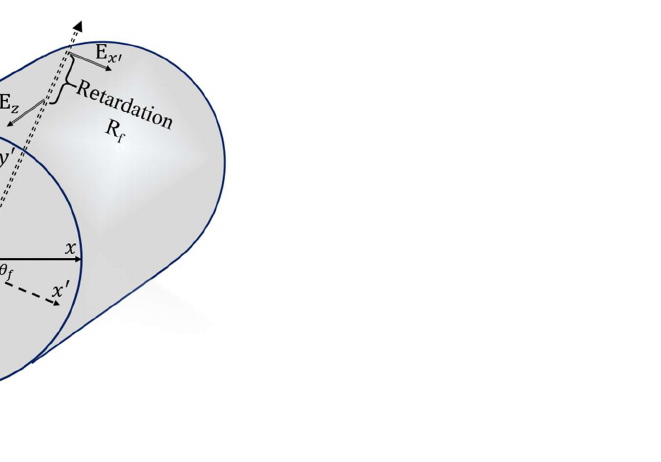
Figure 1. The diagram of optical retardation generated by the polarized beam passing through the fiber. According to the stress-optic law, residual stress can change the fiber RI, and the spe- cific expression is n n C (1) 0 where n 0 is the isotropic fiber RI; C is the elastic optical constant; σ is the residual stress, which can be decomposed into three stress components ( σ x , σ y , and σ z ); and n is the aniso- tropic fiber RI. Next, we solve the fiber mode field distribution under the changed fiber RI, n . An optical fiber is a circularly symmetric regular optical waveguide, and its RI has invariance on the z -axis, that is,